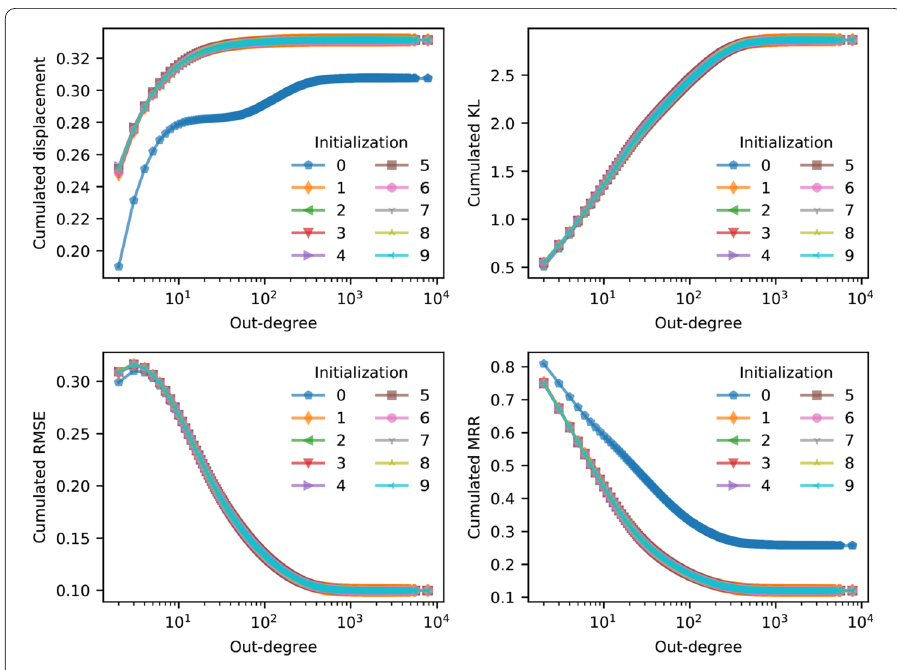
Figure 6 Cumulated evaluation metrics on the Wikipedia network for various initializations of Θ . 0 corresponds to our default deterministic strategy for setting all initial values of Θ to zero. Values for Θ were chosen randomly from the interval [0,1] for the remaining 9 initializations